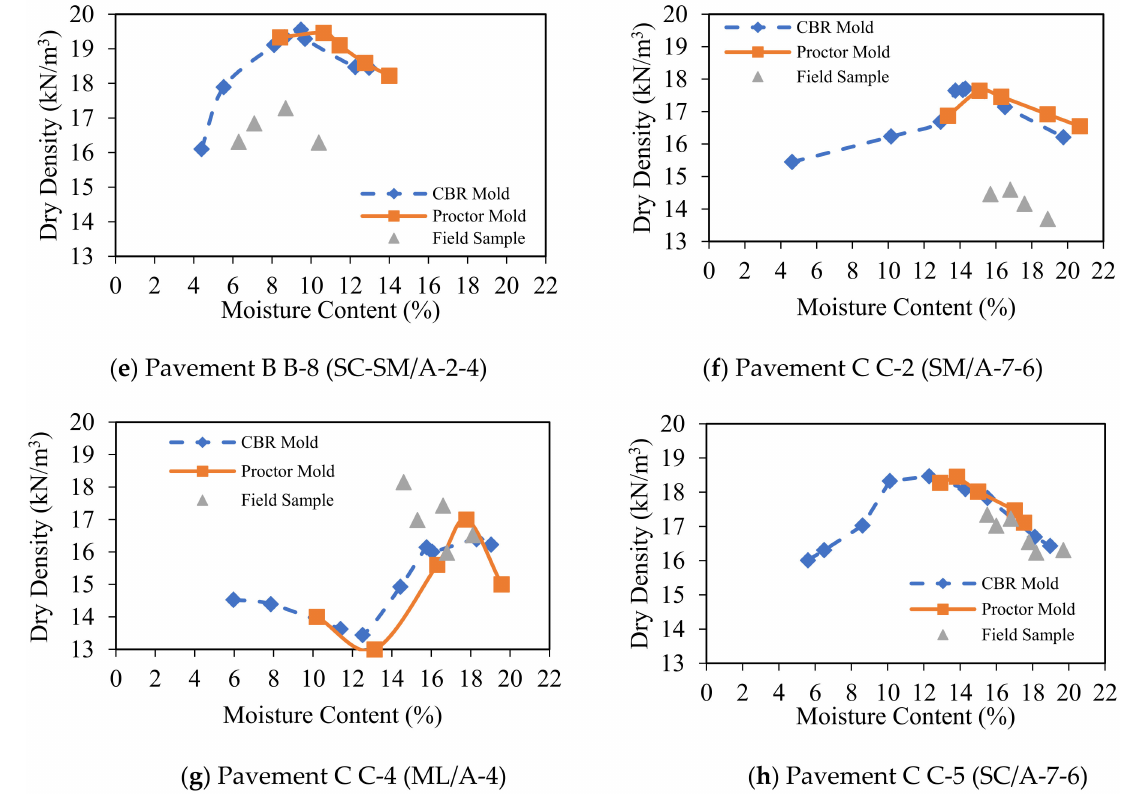
Figure 1. Relationships between Density and Moisture Content.